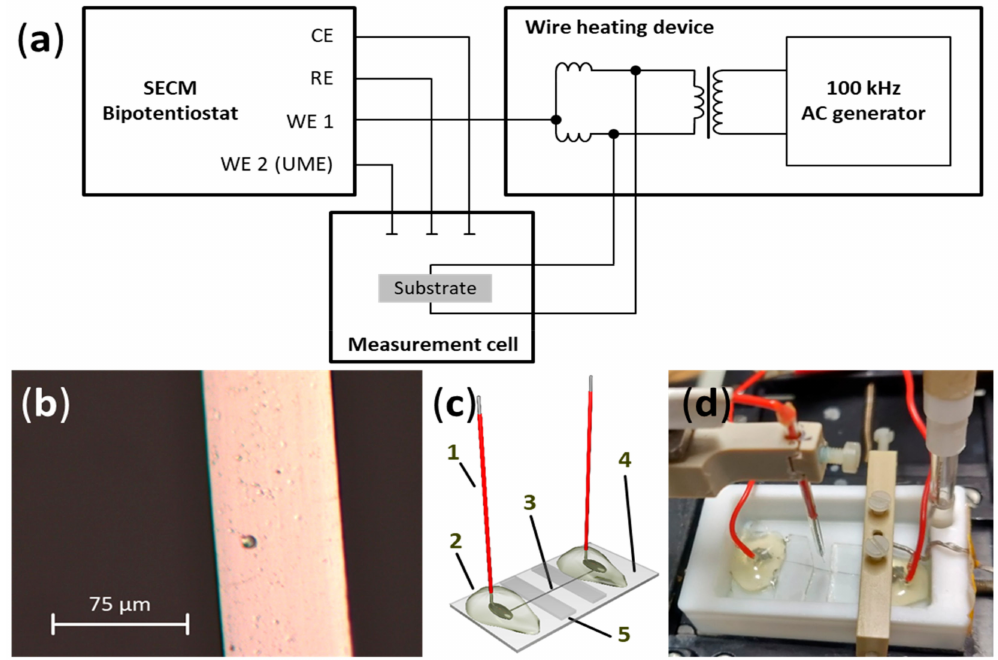
Figure 5. ( a ) Schematic representation of the experimental setup, showing the electrical connections between the SECM bipotentiostat, AC generator, and measurement cell (scheme adapted from [13]). ( b ) Micrograph of a flattened Pt wire. ( c ) Scheme of a hot-wire substrate used in experiments. 1: Copper cables soldered to the Pt wire. 2: Hot glue for insulation of electrical contacts. 3: Flattened Pt wire. 4: Photoresist-covered glass sheet. 5: Glass sheets for wire stabilization. ( d ) Image of the measurement cell used for SECM measurements, containing electrodes and hot-wire